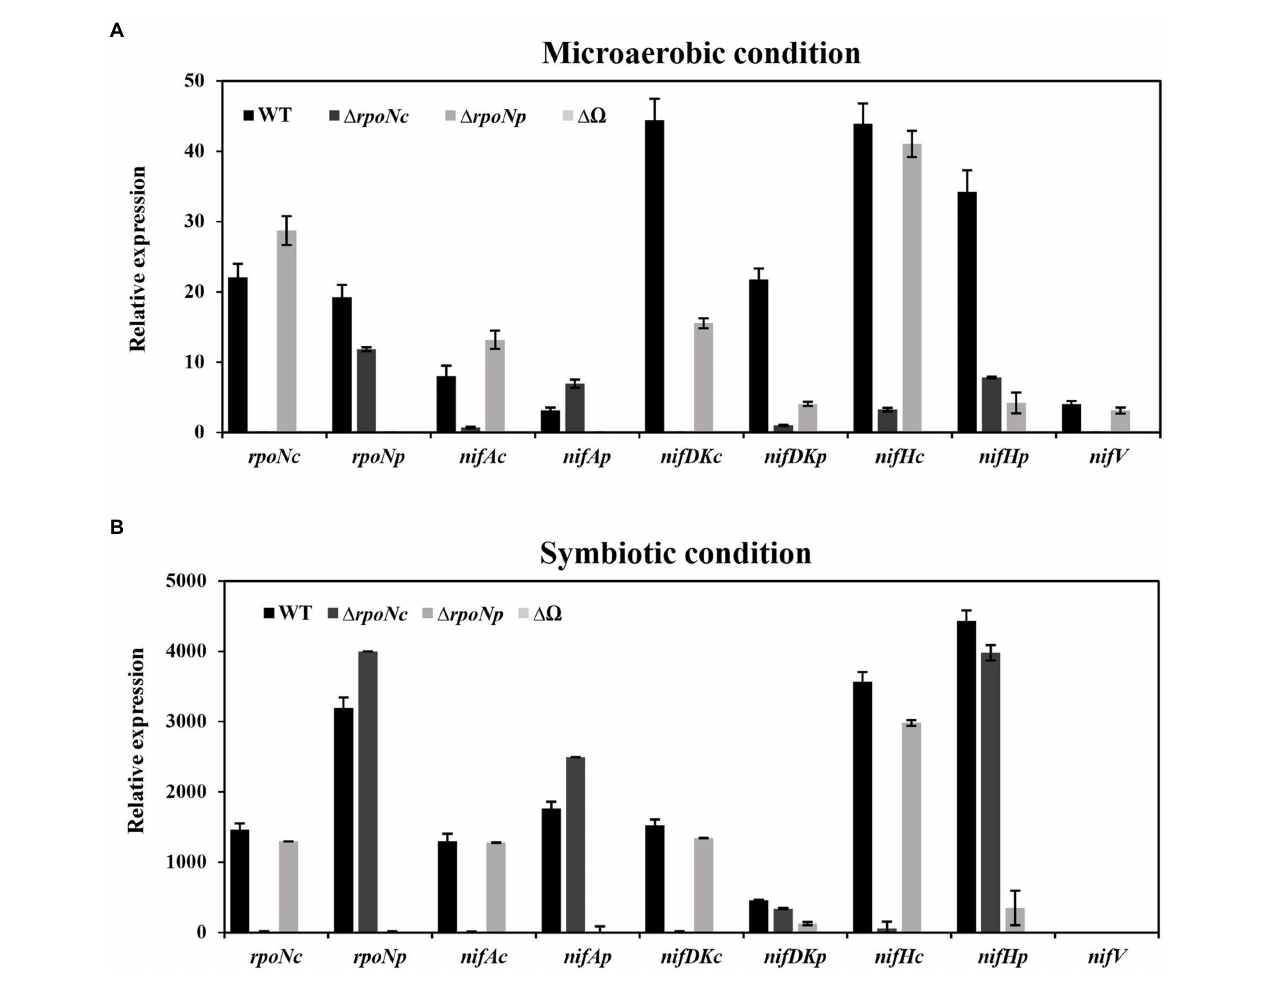
FIGURE 6 Expression of nitrogen fixing genes ( rpoNc , rpoNp , nifAc , nifAp , nifDKc , nifDKp , nifHc , nifHp, and nifV ) in DOA9 WT and Δ rpoNc , Δ rpoNp, and Δ rpoNp :: Ω rpoNc ( ΔΩ ) mutant strains under free-living (A) and symbiotic conditions (B) . Total RNA was extracted and expression of nif genes was determined by quantitative reverse transcription-PCR (qRT-PCR) using 16S RNA as internal standard. Results are the average of three independent